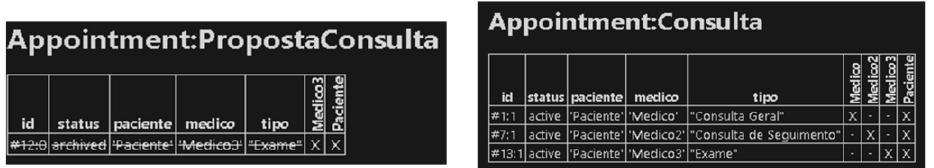
Figure 7. Application print